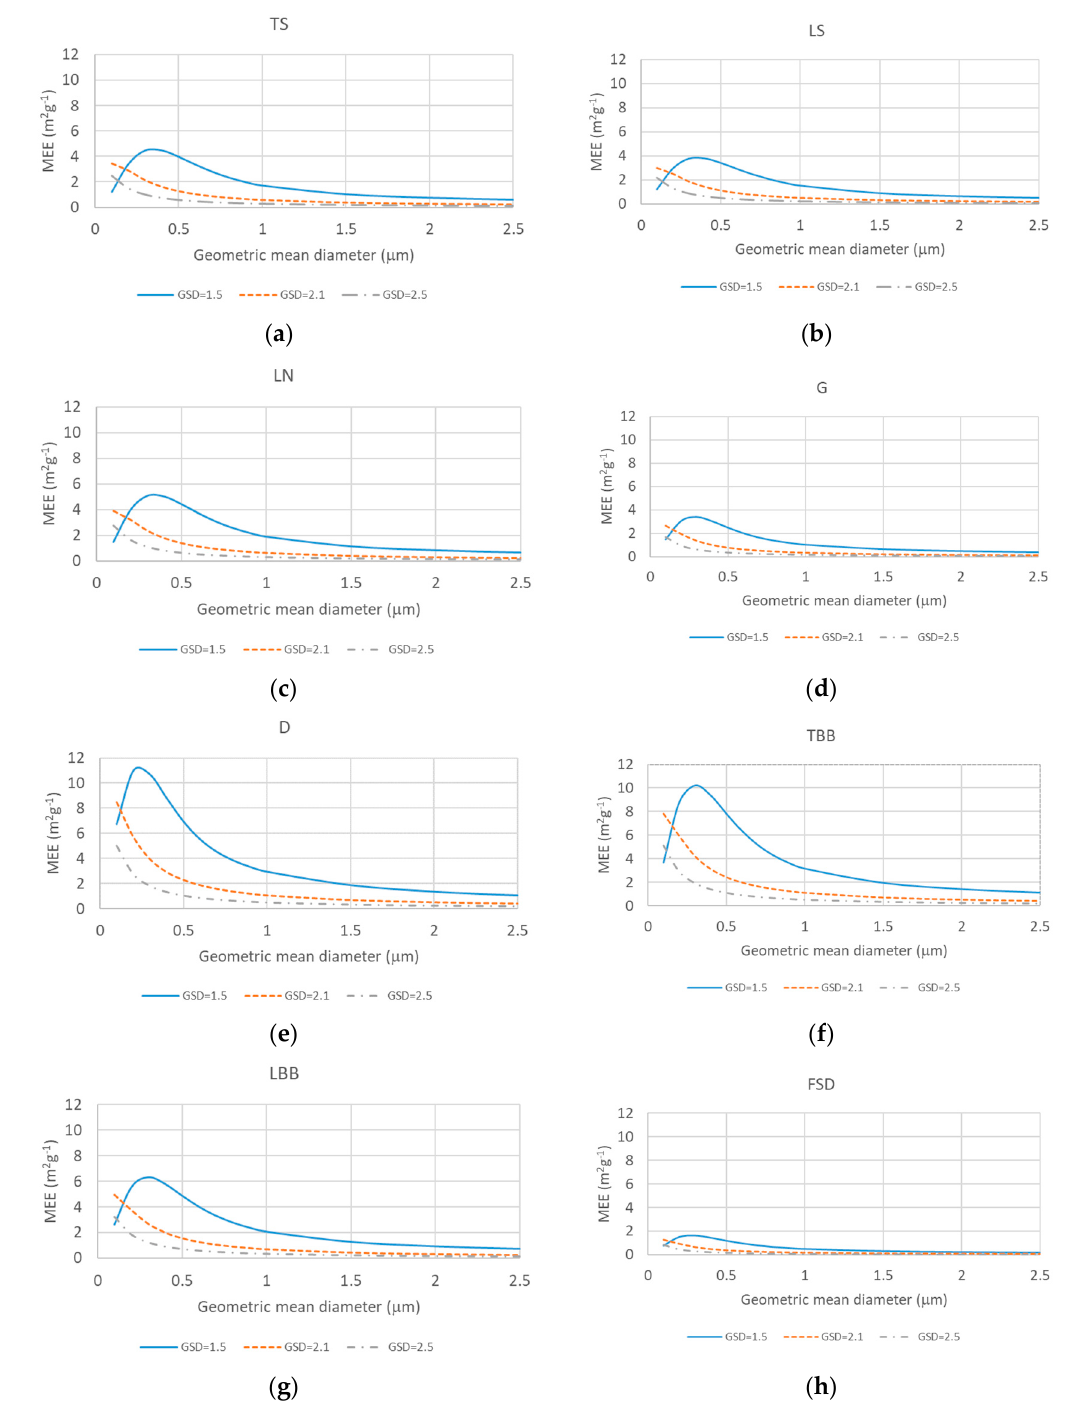
Figure 4. Source-based mass extinction efficiency as a function of the geometric mean diameter for different geometric standard deviations for ( a ) transported secondary sources (TS), ( b ) local secondary sulfates (LS), ( c ) local secondary nitrates (LN), ( d ) gasoline (G), ( e ) diesel (D), ( f ) transported biomass burning (TBB), ( g ) local biomass burning (LBB), and ( h ) fugitive soil dust (FSD). As the properties (MEE, MAE, and MSE) are size-dependent for each chemical compound and source, there are many ranges depending on GSD and d g . Table 2 shows the ranges of MEE, MAE, and MSE for each source for GDS of 1.5–2.5 and d g of 0.1–2.5 µm. The values extended over a wide range. Taking TS as an example, the maximum MEE, MAE, and MSE ranged from 0.098 to 4.471,